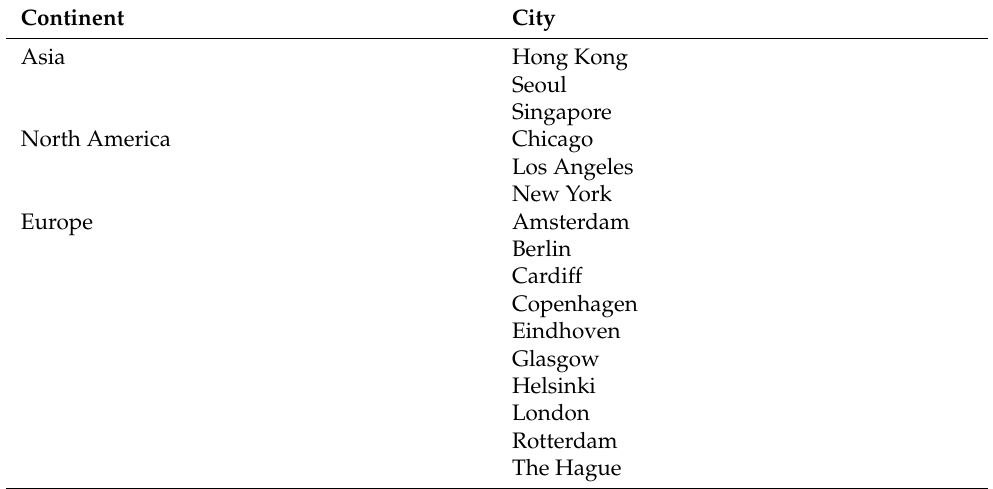
Table 4. Overview of cities included in our search.